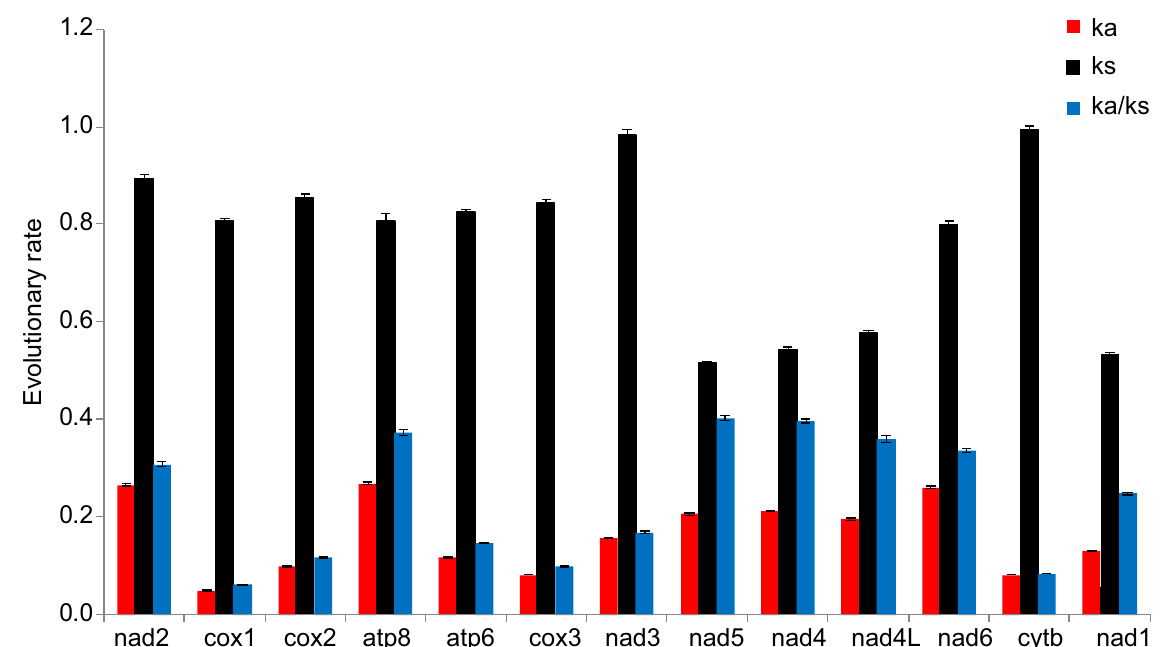
Fig 3. Evolutionary rates of 13 protein-coding genes in the mitogenome of 31 Coreoidea. Red represents nonsynonymous nucleotide substitutions per nonsynonymous site (Ka); black represents synonymous nucleotide substitutions per synonymous site (Ks); blue represents the ratio of Ka to Ks (Ka/Ks). Error bars presented the standard error of